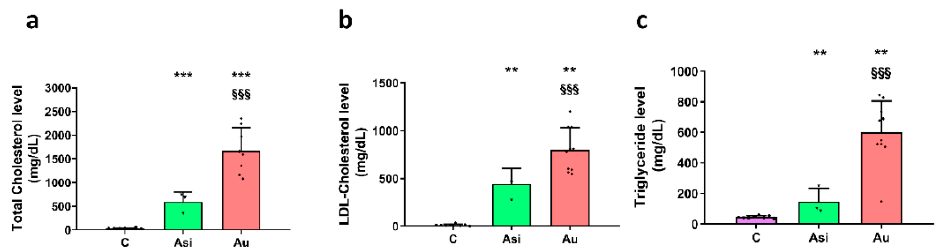
Figure 2. Serological measurements of total cholesterol ( a ) LDL-cholesterol, ( b ) triglycerides, ( c ) from control: C, PCSK9 siRNA and statin-treated hyperlipidemic: Asi and advanced hyperlipidemic: Au samples. The statistical significance over C samples is represented by * (** p < 0.01, *** p < 0.001), while the one over Asi is visible with § (§§§ p < 0.001).